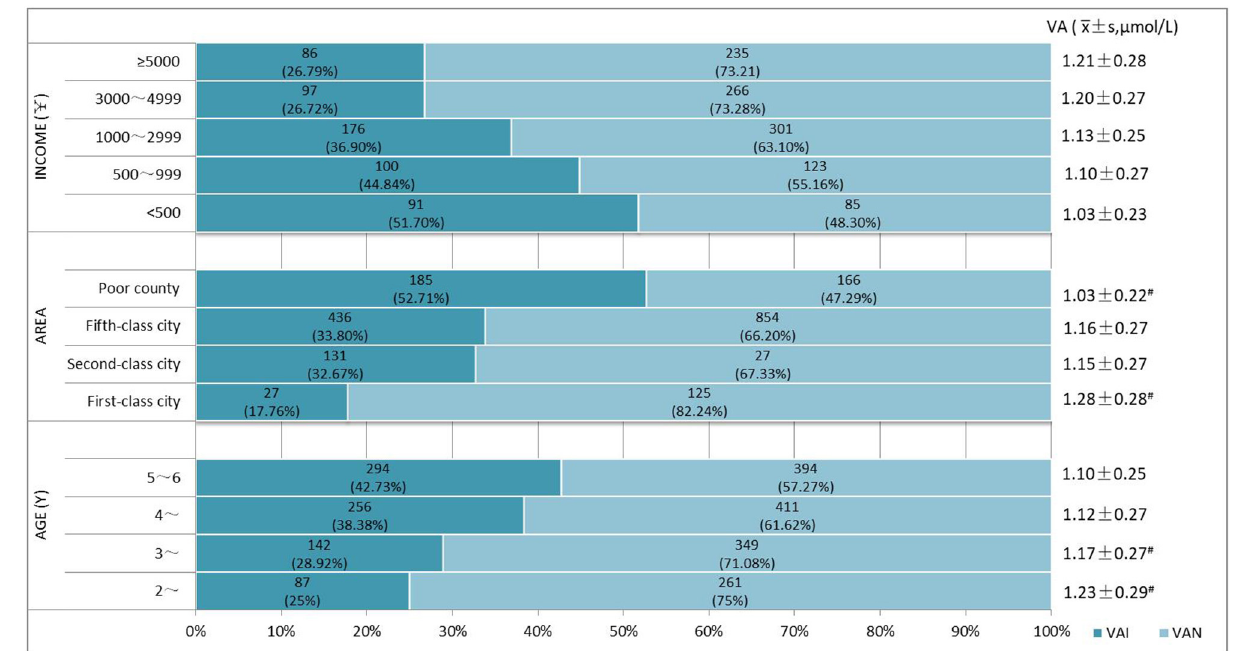
Higher percentages of children aged 2–3 years (11.29%, 35/310) and aged 3–4 years (6.70%, 30/448) were administered vitamin A supplements, compared with children aged > 4 years (3.35%, 39/1,163). Regardless of whether the children took